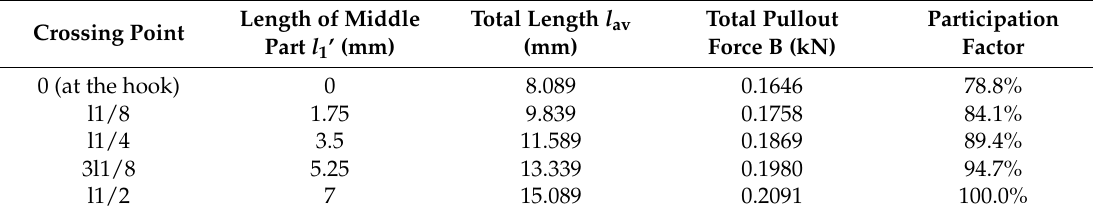
Table 2. Participation factor of a fiber, in accordance with the intersection point with a crack.